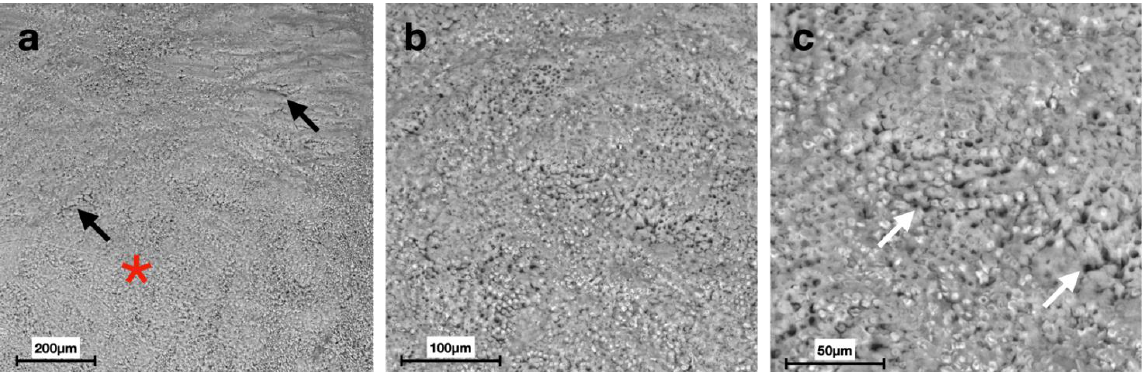
Figure 5. Scanning electron micrographs of G2 (Nanohydroxyapatite group): ( a ) a non-homogeneous surface with intact interprismatic areas (red asterisk) alternated by cracks in the enamel (black arrows) at 200× magnification; ( b , c ) the presence of enamel prisms with partially intact crystals with slight dissolution of the interprismatic area (white arrows) at 500× and 1000× magnification, respec- tively.